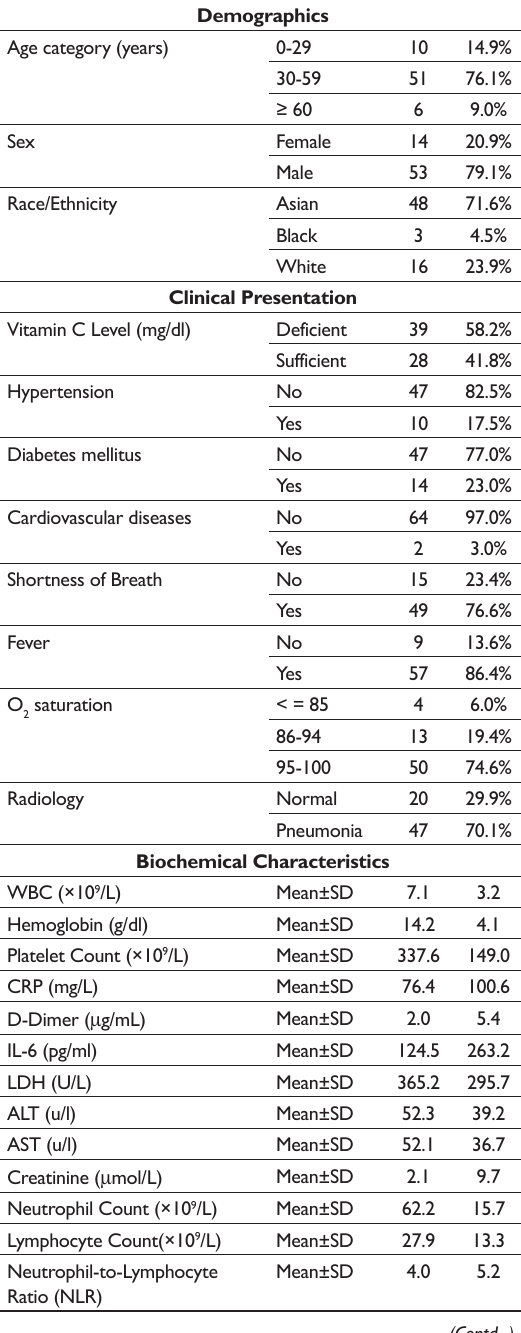
Table 1: Characteristics of COVID-19 patients according to disease severity and mortality